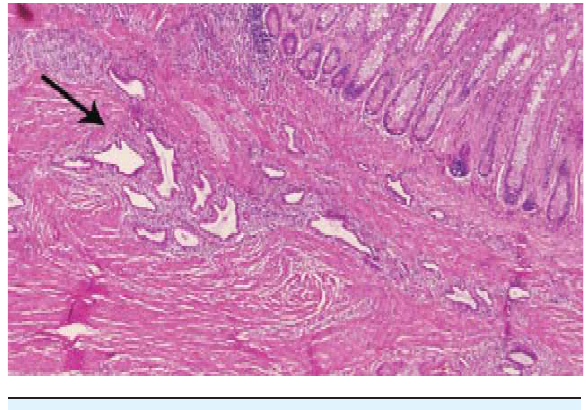
Hisptopatholgical examination of the resected specimen revealed endometriosis. The tissue composed of stroma and glands of endometrium (blackarrow). (HE X